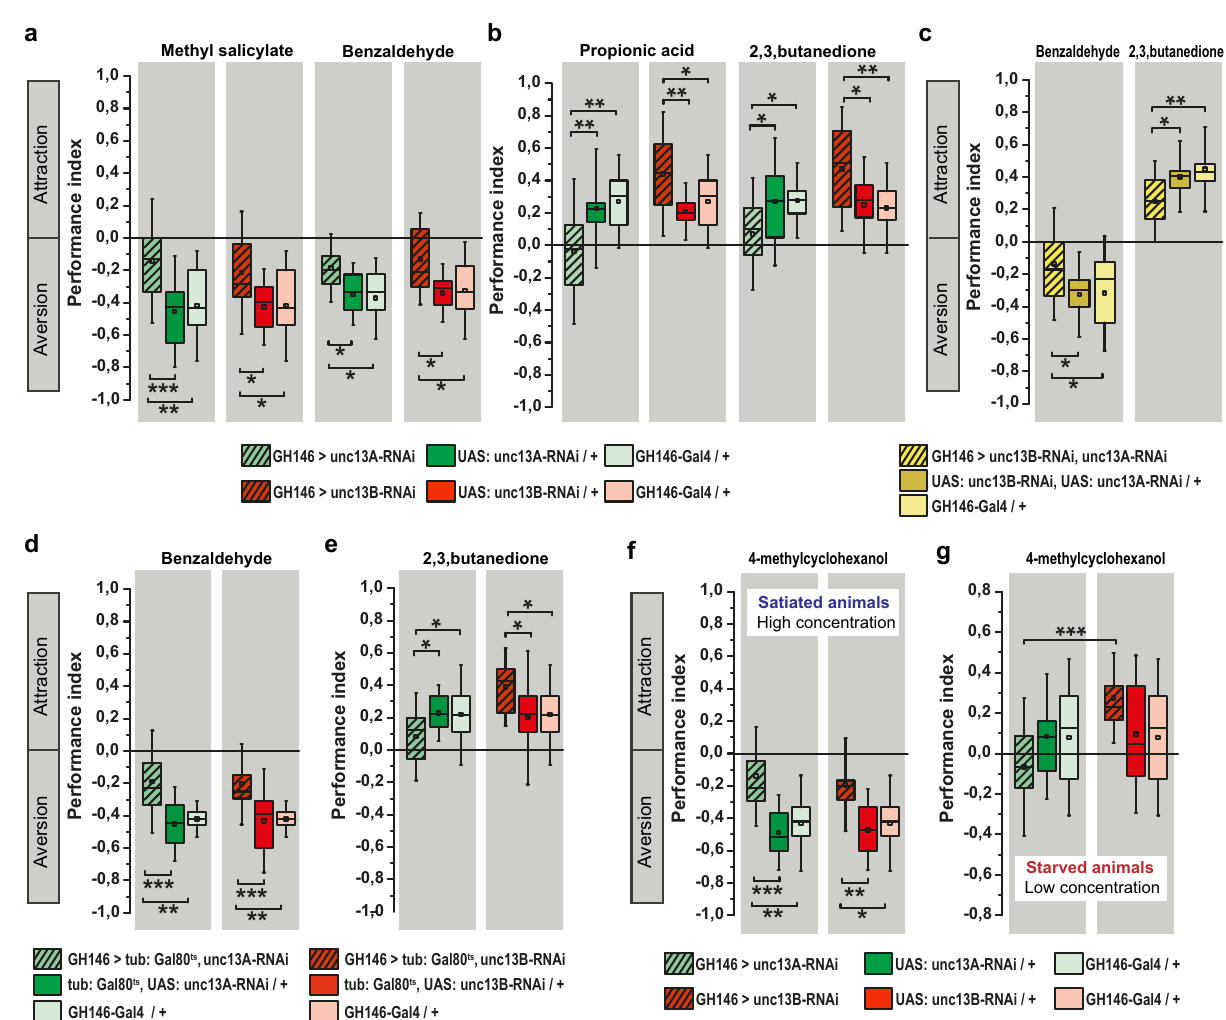
Fig. 4 Distinct behavioral consequences of Unc13A and Unc13B knockdown in ePNs. a Knockdown of unc13A or unc13B under control of GH146-Gal4 signi fi cantly reduces the performance index of animals toward aversive odors, methyl salicylate ( n = 14 – 17) and benzaldehyde ( n = 10 – 12). b Performance index of animals with unc13A knockdown in ePNs under control of GH146-Gal4 shows signi fi cant reduction toward appetitive odors, propionic acid ( n = 16 – 17) and 2, 3-butanedione ( n = 15 – 17), compared with their genetic controls. Downregulation of unc13B under control of GH146-Gal4 leads to increased attraction toward appetitive odors, propionic acid ( n = 17), and 2, 3-butanedione ( n = 16 – 17). c Performance index of animals with simultaneous unc13A and unc13B knockdown in ePNs under control of GH146-Gal4 shows a signi fi cant reduction toward appetitive odor, 2, 3-butanedione ( n = 14 – 17), and aversive odor, benzaldehyde ( n = 17 – 22), compared with the genetic control. d Knockdown of unc13A or unc13B under control of GH146-Gal4 during adult stage using tub: Gal80 ts signi fi cantly reduces the performance index of animals toward aversive odor benzaldehyde ( n = 12 – 17). e Performance index of animals with unc13A knockdown in ePNs under control of GH146-Gal4 during adult stage shows signi fi cant reduction toward appetitive odor, 2, 3-butanedione ( n = 18 – 25) compared with their genetic controls. Knockdown of unc13B under control of GH146-Gal4 during adult stage leads to an increased attraction toward appetitive odor, 2, 3-butanedione ( n = 23 – 25). f Knockdown of unc13A or unc13B under control of GH146-Gal4 signi fi cantly reduces the performance index of satiated animals toward high concentration of aversive odor 4-methylcyclohexanol ( n = 10 – 12). g Knockdown of unc13A under control of GH146-Gal4 signi fi cantly reduces the performance index of starved animals toward low concentration of aversive odor 4-methylcyclohexanol ( n = 17 – 23) in comparison to the starved animals with unc13B knockdown in ePNs. All p values were calculated via one-way ANOVA with the Bonferroni multiple comparison post